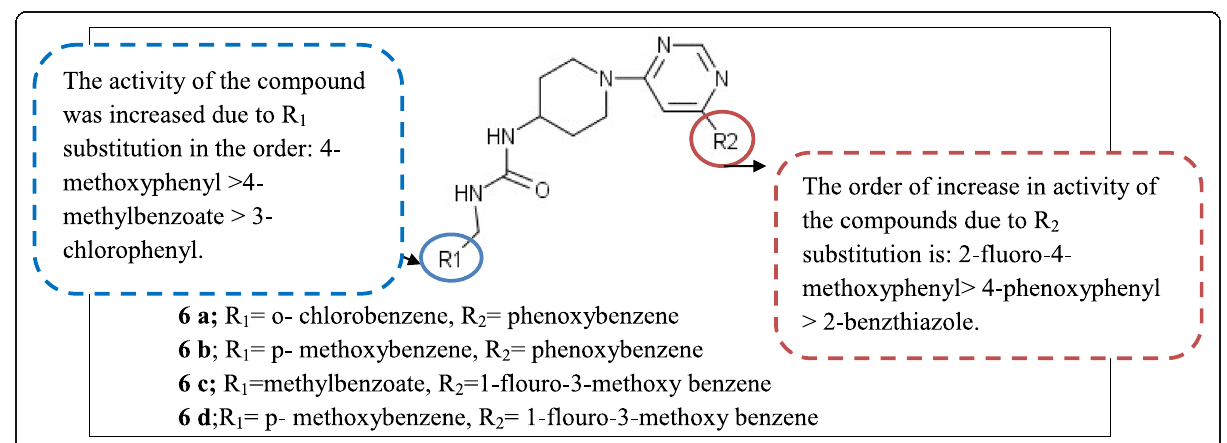
Fig. 3 Chemical structures and SAR studies of novel 4, 6-disubstituted pyrimidine